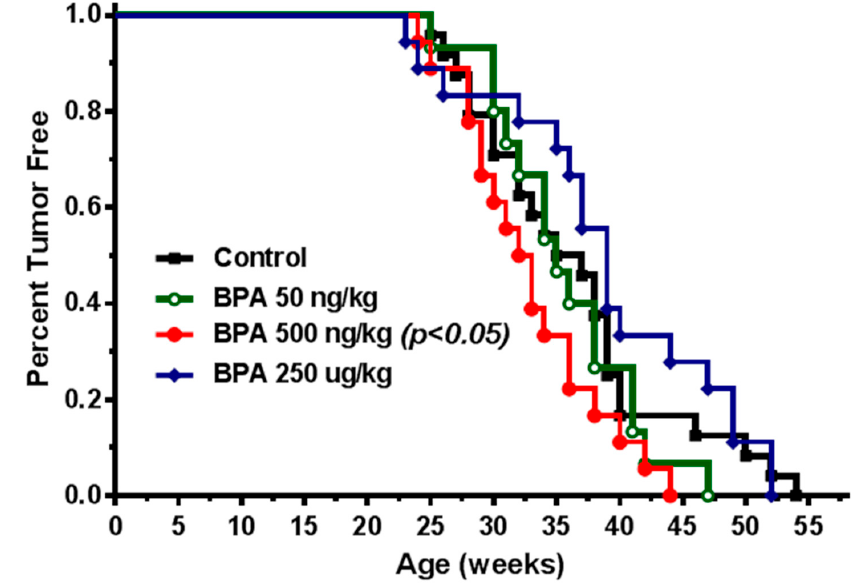
Figure 1. In utero exposure to low dose Bisphenol A (BPA) promotes mammary tumor development in MMTV-erbB2 transgenic mice. Kaplan–Meier tumor free survival curves were calculated based on tumor latency of the MMTV-erbB2 transgenic mice ( n = 20 mice per group) with in utero exposure to 0 (square), 50 ng / kg (circle), 500 ng / kg (dot), or 250 µ g / kg (diamond) bodyweight of BPA daily between GD 11 and